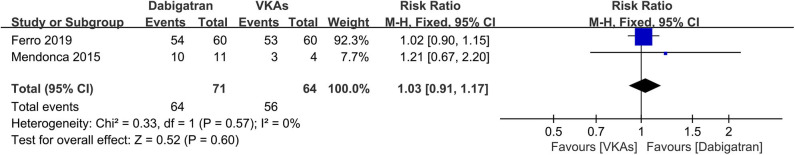
Excellent clinical outcome between dabigatran and VKAs.